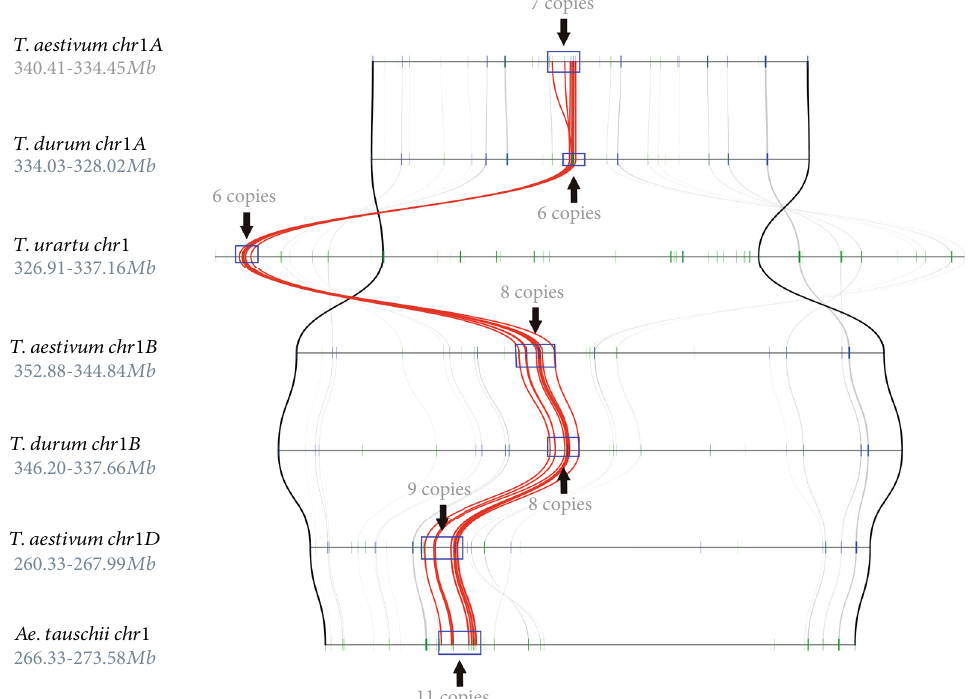
Figure 4: Microsynteny analysis of a glutathione S-transferase (GST) gene cluster on chromosome 1 of common wheat and its relatives. Syntenic GST genes are linked by red lines; the chosen genomic border is represented by black lines, and others by gray